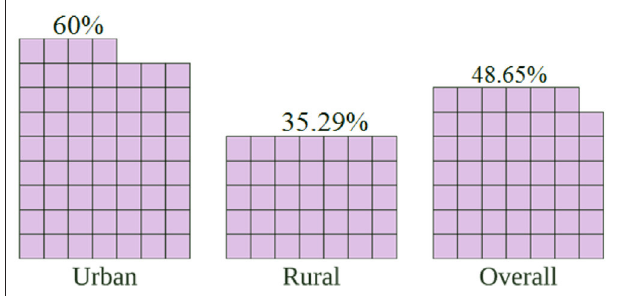
FIGURE 3 | Percentage of urban, rural, and all participants (overall) who faced a negative impact on